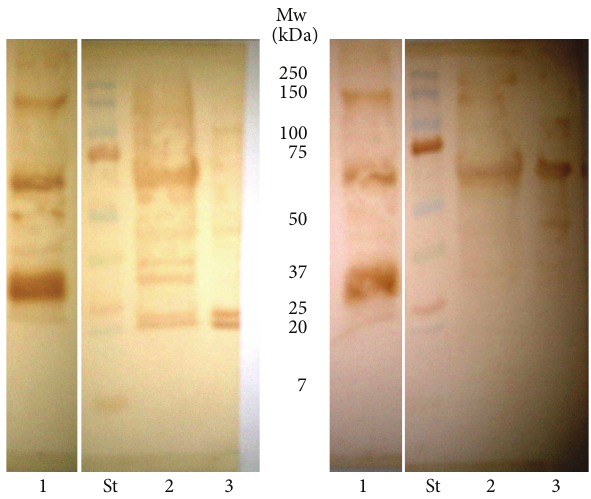
Figure 1: Western blot analysis of the isolated proteins: (1) human peripheral nerve, (2) C. jejuni O:19-GBS, and (3) C. jejuni O:19- enteritis, incubated with sera from patients with